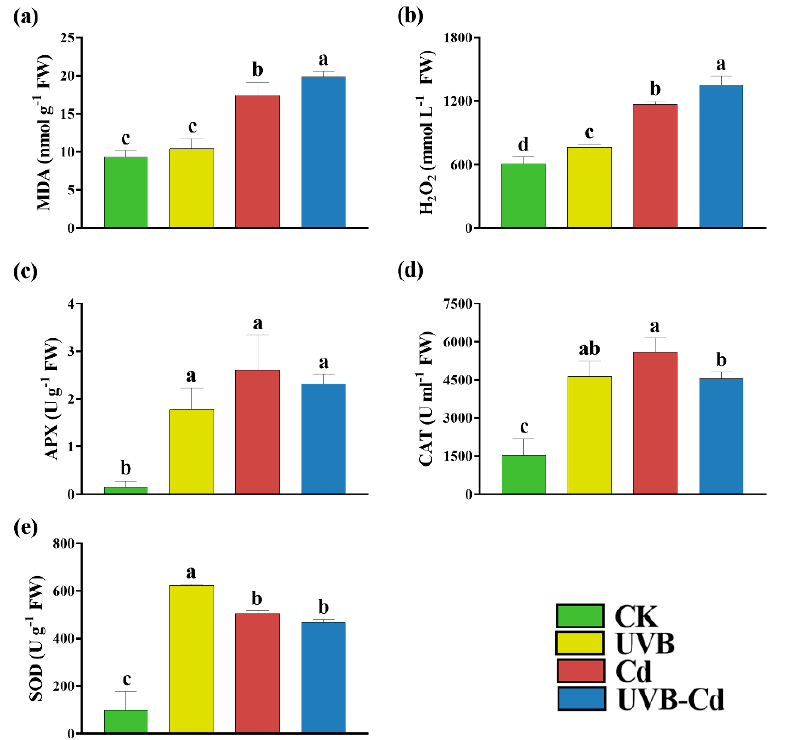
Figure 3. Indicators related to the antioxidant capacity of 84K poplar leaves in different treatment groups. The content of MDA ( a ) and H 2 O 2 ( b ), APX ( c ), CAT ( d ), and SOD ( e ) of poplar leaves in different treatment groups ( n = 9 plants for each treatment). Different letters represent significant differences among four treatment groups ( p < 0.05).